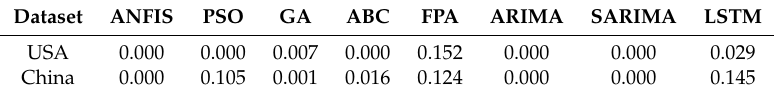
Figure 4. The results of real and forecasted data for influenza cases in China. ( a ) ANFIS, ( b ) PSO, ( c ) GA, ( d ) ABC, ( e ) FPA, ( f ) FPASCA. Table 3. Statistical results for the FPASCA and the compared